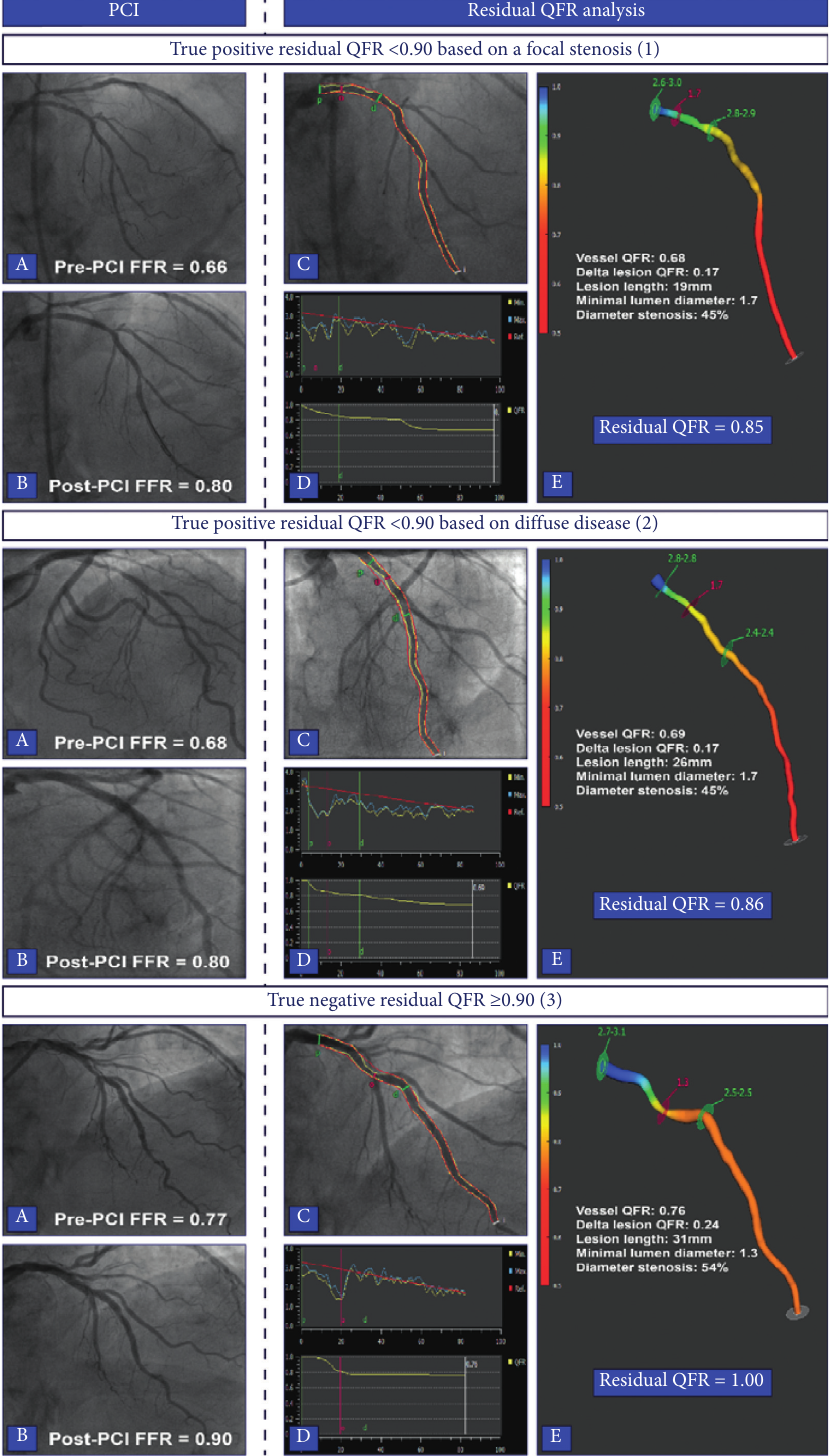
Figure 5: Case examples of true positive and true negative residual QFR results. Case 1 demonstrates a case of a successfully treated proximal LAD lesion with a suboptimal post-PCI FFR (1a-b). Residual QFR estimated a post-PCI FFR of 0.85 (1c–e). The suboptimal result was caused by a pressure drop due to an additional lesion in the mid-LAD (1d). In case 2, residual QFR was 0.86 and FFR after treating the proximal LAD lesion was 0.80 (2a–e). QFR analyses revealed diffuse disease without a focal pressure drop to be the potential cause of the suboptimal result (2D). The last case demonstrates a case of a true negative result; the lesion in the proximal LAD was successfully treated, and there were no additional lesions or diffuse disease which led to a concordant residual QFR and post-PCI FFR ≥ 0.90 (3a–e). FFR, fractional flow reserve; PCI, percutaneous coronary intervention; QFR, quantitative flow ratio; LAD, left anterior descending